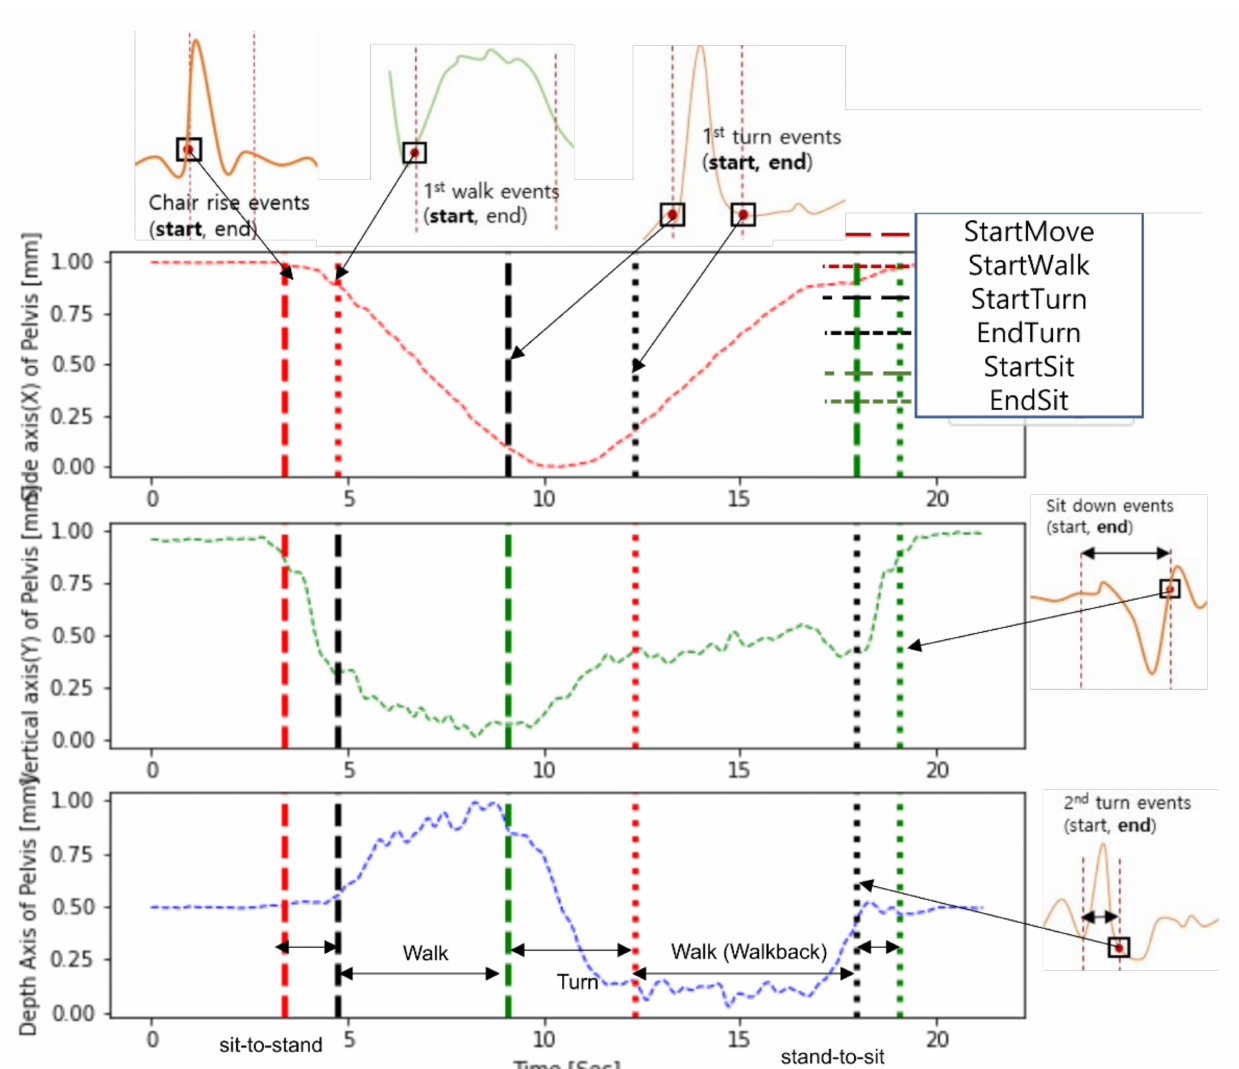
Figure 8. TUG events in Skeleton TUG and this study. Based on the dataset obtained in the study, it shows how the proposed method and the events of the skeleton TUG are matched, re-spectively. Each truncated plot is the result of detection of the event of the skeleton